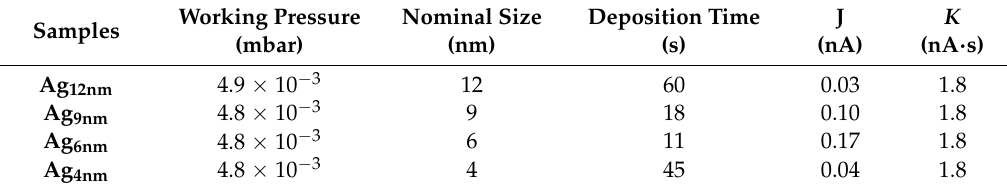
Table 1. Deposition details for a series of silver nanoparticle specimens with nominal diameters in the 4 to 12 nm range. Argon flow, magnetron position, and NP current where set at 60 sccm, 8.5 cm, and 60 mA respectively. The substrate was grounded and the size was selected using the MesoQ